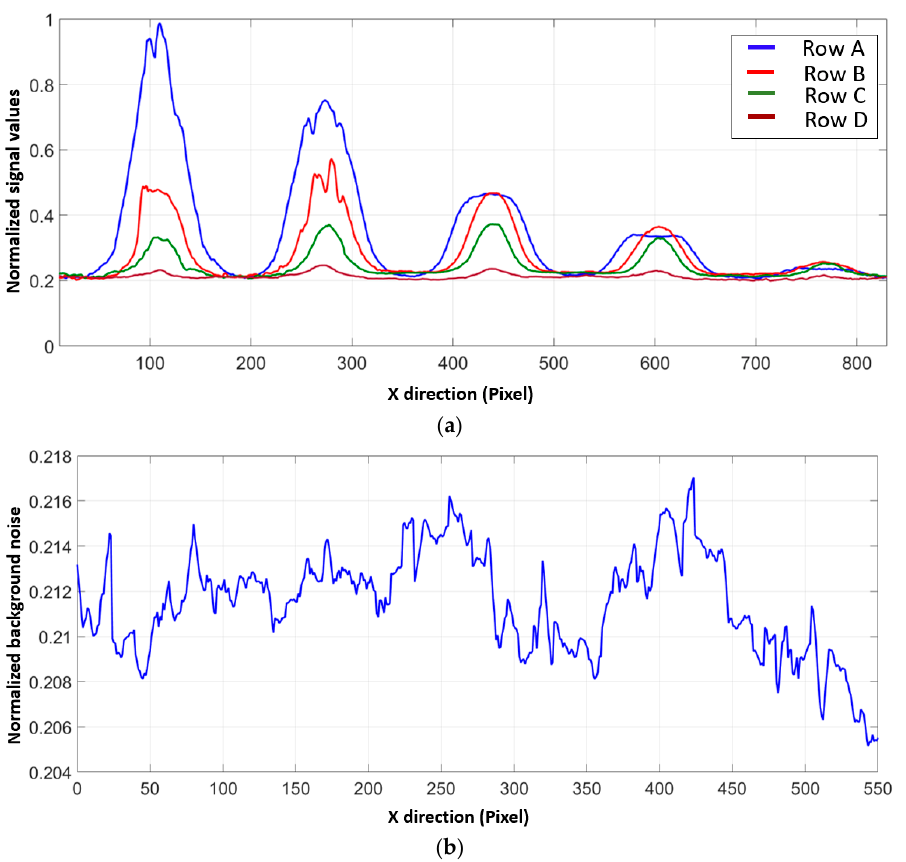
Figure 8. ( a ) Normalized signal values along the defect rows and ( b ) background noise around A2.